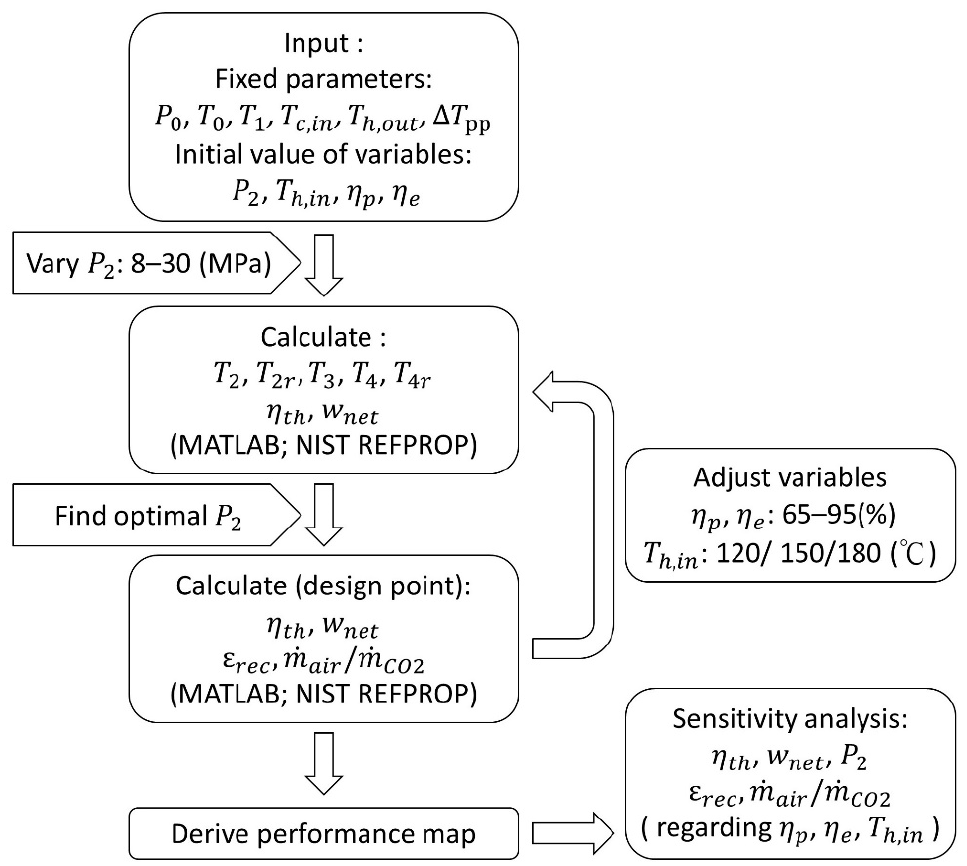
Figure 3. Schematic of the simulation process.